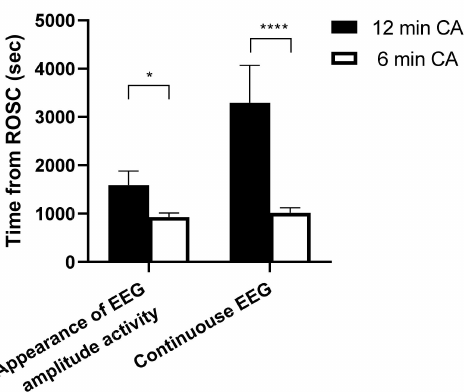
Figure 2. Brain electrical recovery after cardiac arrest/cardiopulmonary resuscitation. The duration of both the appearance of the first EEG amplitude activity and continuous EEG activity were significantly longer in the 12 min CA group than in the 6 min CA group. Data are presented as mean ± SD. n = 5